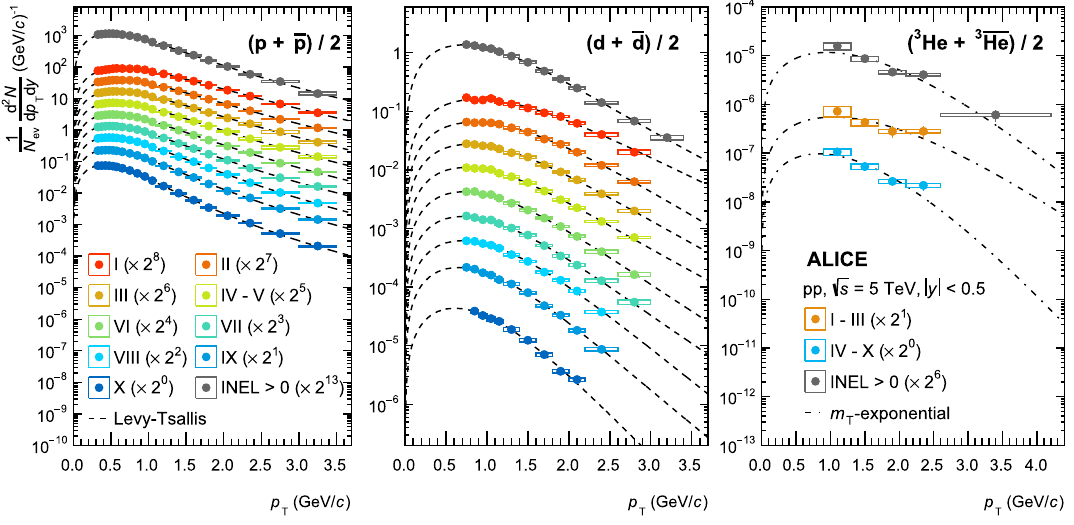
Fig. 1 Transverse-momentum spectra of (anti)protons (left), (anti)deuterons (center) and (anti)helions (right) in the different mul- tiplicity classes, reported in Table 1. (Anti)deuteron and (anti)proton